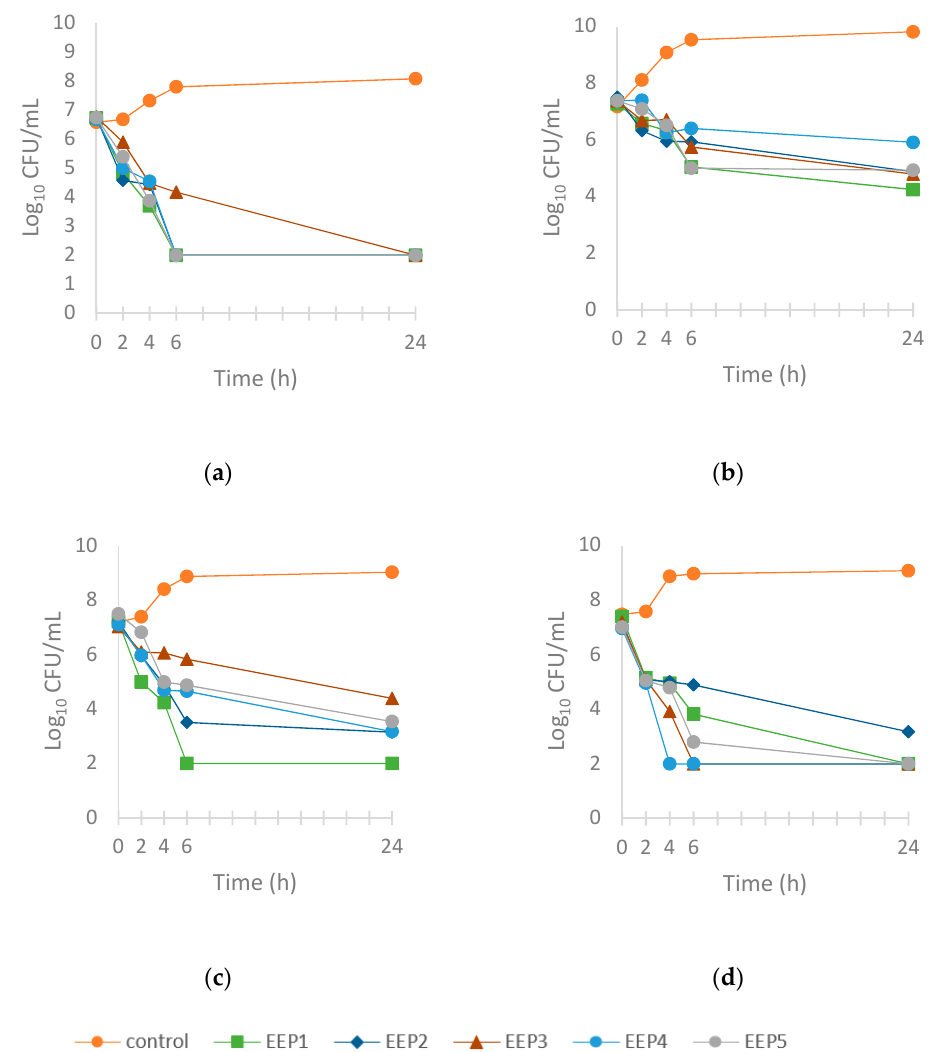
Figure 2. Time-kill curves shows of ethanol extracts of propolis against bacteria. ( a ) S. aureus , ( b ) L. monocytogenes , ( c ) S. Enteritidis, ( d ) E. coli